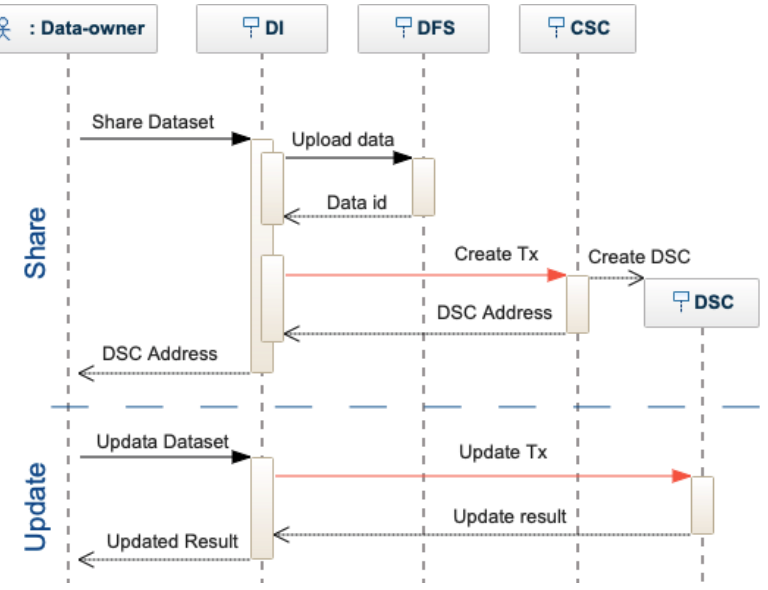
Figure 5. Sequence diagram for sharing and updating a